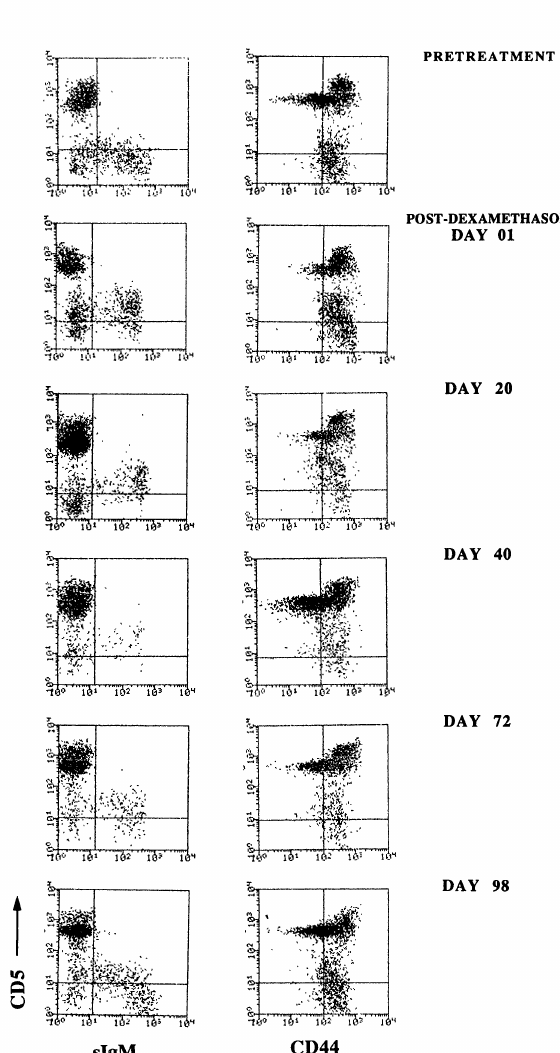
FIGURE 8. Phenotypic analysis of B and T lymphocytes present in blood before and after dexamethasone treatment (2 mg/kg for 7 days). In young lambs (pretreatment), few B-cells expressed detectable levels of CD5, but immediately following dexametha- sone treatment (postdexamethasone: day 01), most sIgM B-cells expressed a low level of CD5. The predominance of CD5 IgM B-cells persisted for 14 weeks posttreatment (postdexamethasone day 98) with a minor subpopulation of CD5-sIgM B-cells. The changes in CD5 +IgM/B-cell number were reflected in the lo h CD5 CD44 population. In young lambs (pretreatment), T-cells